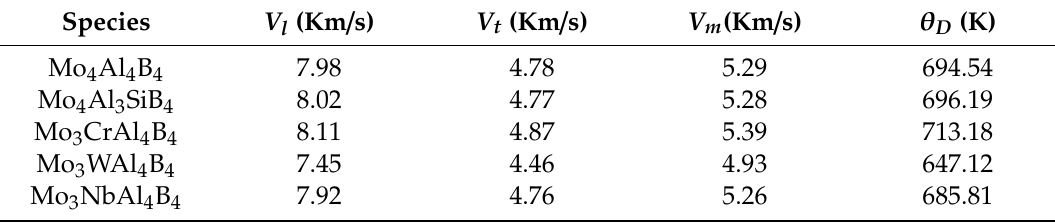
Table 6. The calculated average, transversal, and longitudinal sound velocities of MoAlB.